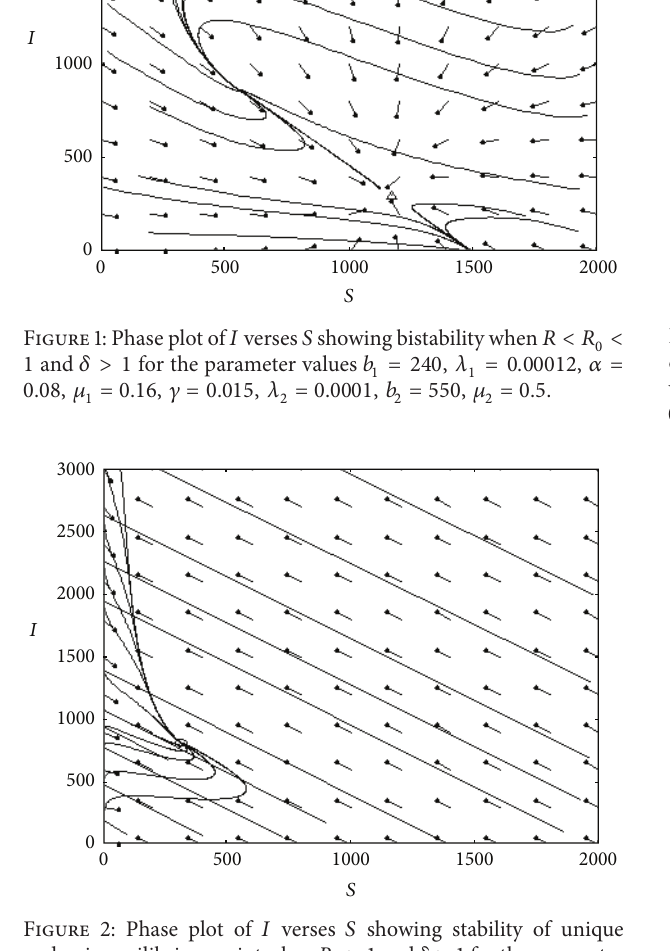
Figure 4: Phase plot of 𝐼 verses 𝑆 showing stability of unique feasible endemic equilibrium point and instablity of disease free equilibrium point when 𝛿 < 1 , 𝑅 0 > 1 for the parameter values 𝑏 1 = 10 , 𝜆 1 = = 0.01 , 𝛾 = 0.01 , 𝜆 = 0.0003 , 𝑏 = 60 , 𝜇 = 0.0005 , 𝛼 = 0.01 , 𝜇 1 2 2 2 0.5